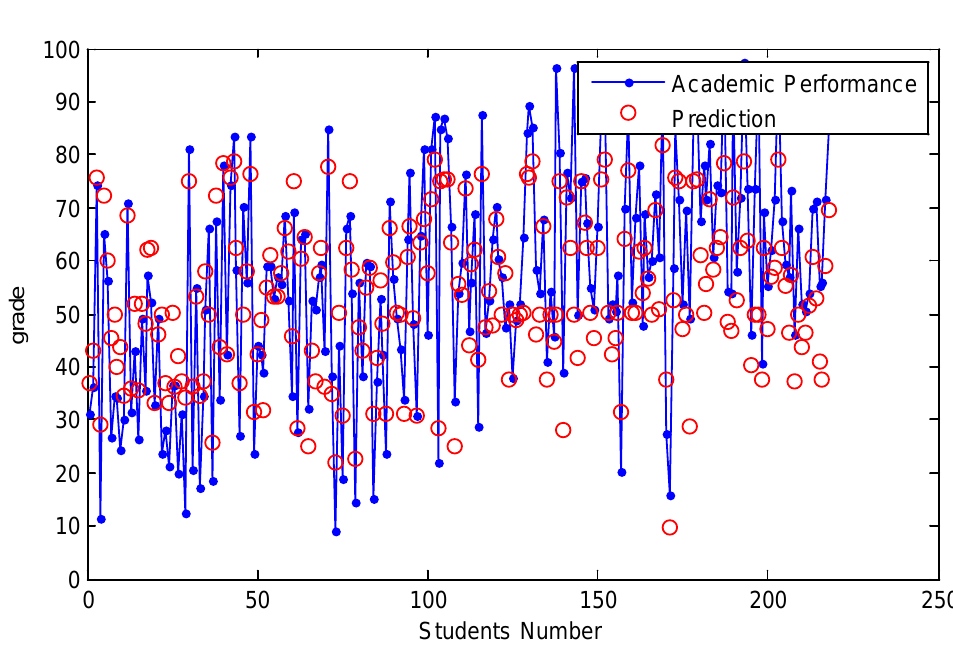
Graph 2. Comparison graph for academic performance and